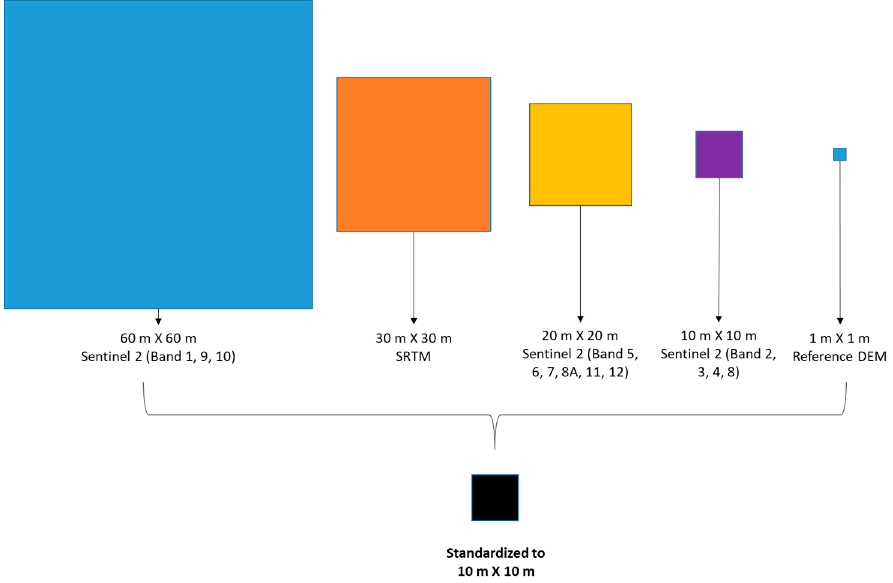
Figure 3. Standardization of different resolutions from different sources.